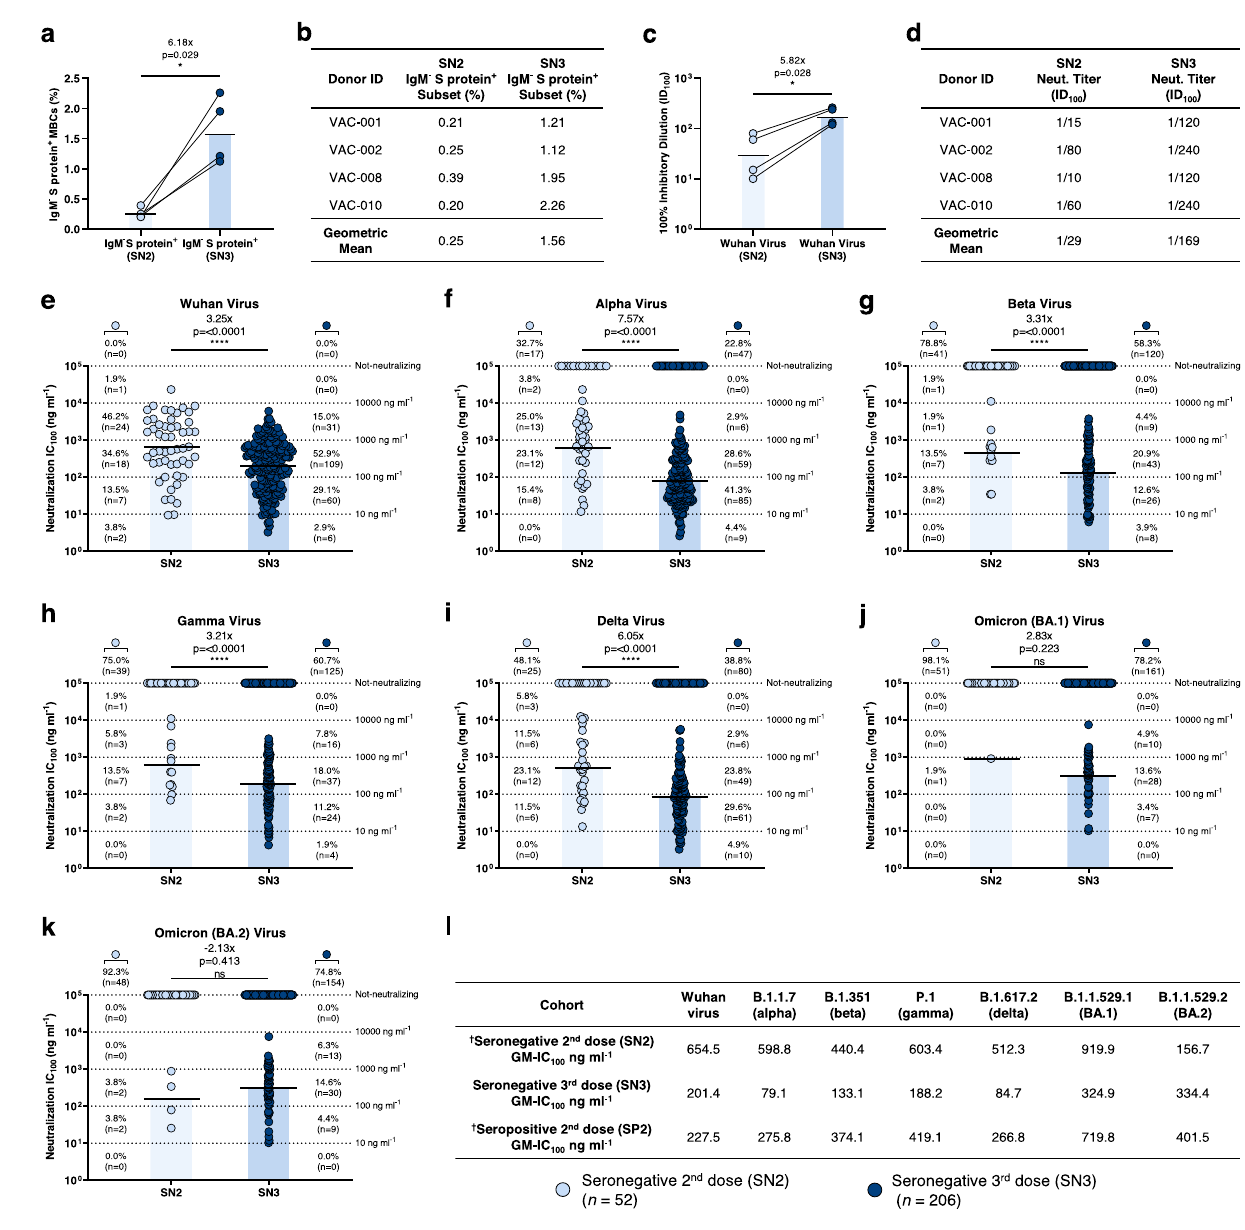
Fig. 1 | Potency and breadth of neutralization of nAbs against SARS-CoV-2 and VoCs. a The graph shows the frequency of CD19 + CD27 + IgD − IgM − able to bind the SARS-CoV-2Sprotein trimer(Sprotein + ) in SN2and SN3donors( n =4/group).The black line and bars denote the geometric mean. b The table summarizes the fre- quencies of the B cell populations in SN2 and SN3. c The graph shows the neu- tralizingactivityofplasmasamplesagainsttheoriginalWuhanSARS-CoV-2virusfor SN2 ( n =4) and SN3 ( n =4). Technical duplicates were performed for each experi- ment. d Thetablesummarizesthe100%inhibitorydilution(ID 100 )ofeachCOVID-19 vaccinee and the geometric mean for SN2 and SN3 ( n =4/group). e – k Scatter dot charts show the neutralization potency, reported as IC 100 (ng ml − 1 ), of nAbs tested